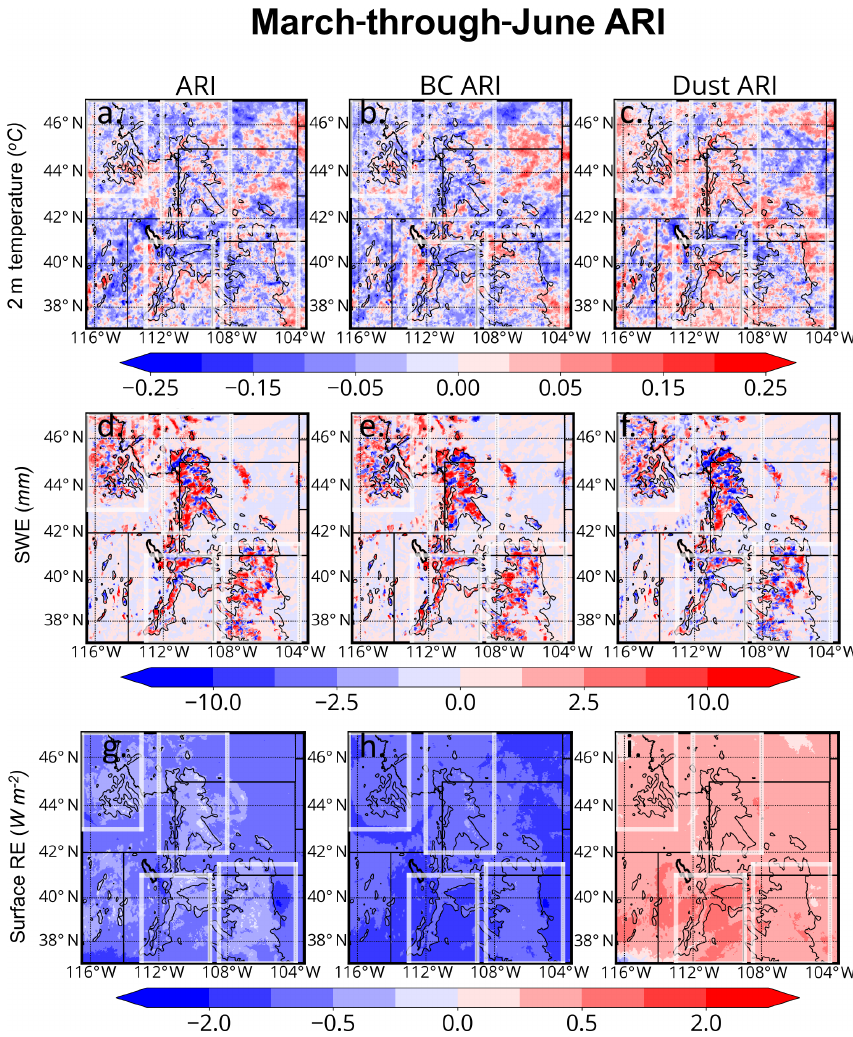
Figure 10. Same as in Fig. 8 but for (a, b, c) 2m temperature, (d, e, f) SWE, and (g, h, i) surface radiative effect (RE) due to (g) BC + dust, (h) BC only, and (i) dust only. RE values are computed diagnostically following Ghan et al. (2012).